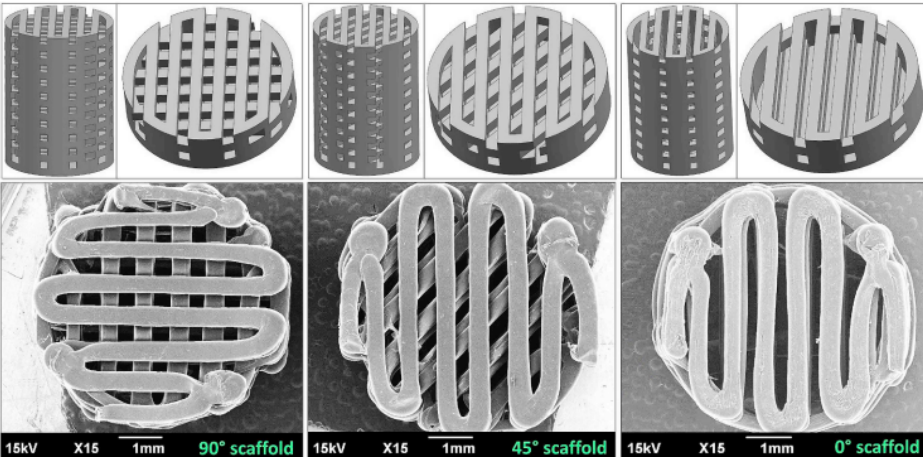
Figure 24. Three-dimensional-printed scaffolds destined for tissue engineering applications. The top view shows the schematic drawing from Solidworks 2016 (Dassault Systèmes, Vélizy-Villacoublay, France). The bottom view shows the original SEM image of the 3D-printed scaffold (MakerBot Z18 3D printer, New York City, New York, USA) [291]. In a similar case, Swetha et al. [292] fabricated 3D-printed PLA/Gel scaffolds and their surface was treated with Mg-nHAp in varying concentrations. Three-dimensional- PLA/Gel/Mg-nHAp scaffolds presented a uniform interconnected porous architecture. However, the porosity of the prepared scaffolds was decreased by the increasing of Mg- nHAp content (from 0.5 wt.% to 1.5 wt.%). The biological analysis showed that PLA/Gel/Mg-nHAp scaffolds exhibited improved protein adsorption in 24 h when com- pared with three-dimensional-PLA, which was attributable to their suitable porous